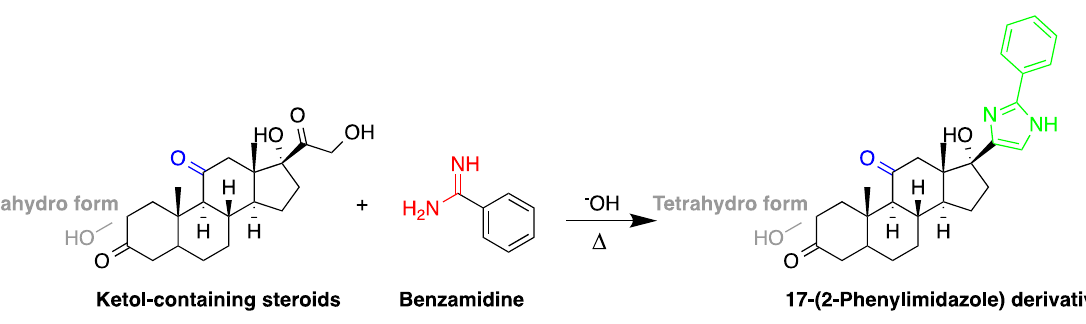
Figure 8. Fluorescent derivatization of ketolic-containing corticosteroids by benzamidine. The utilization of ketolic groups was also performed by Yamaguchi et al. to detect and quantify corticosteroids in urine after their conversion into fluorescent quinoxalines (Figure 9) [67]. They detected nineteen 21-hydroxycorticosteroids in human urine samples achieving LOD = 0.14–29.4 pmol/50 μ L injection volume (S/N = 3). In another study by the same group, prednisolone and prednisone were quantified in plasma samples following similar derivatization procedure and analyzed by reversed-phase liquid chromatography with isocratic elution. The LOD of prednisolone and prednisone was 3 ng/mL in plasma (S/N = 3) [65].